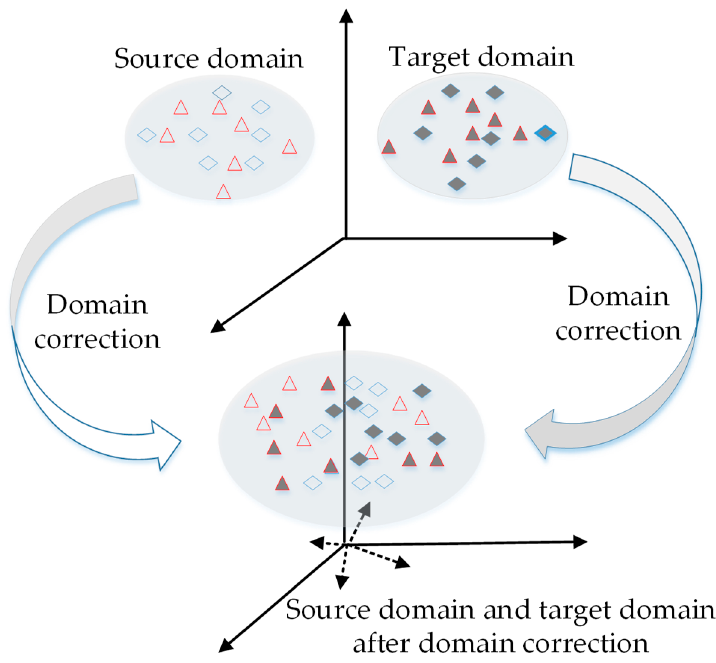
Figure 1. Schematic diagram of the proposed DCKT method.